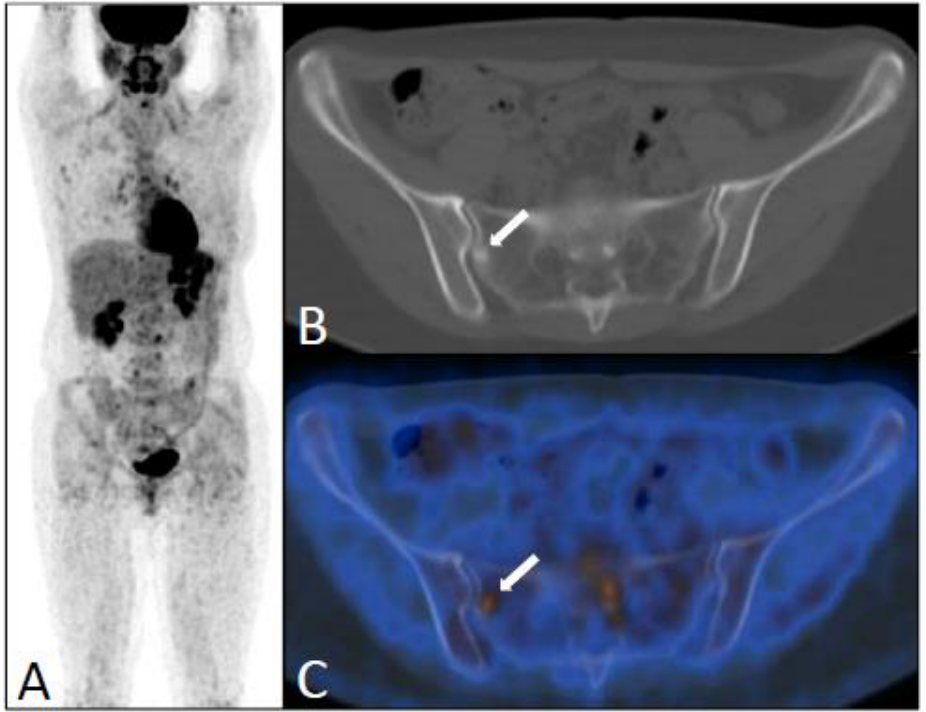
Figure 3. An FDG-PET/CT scan performed five years after the initial diagnosis of ILC (pT3N2, SBR II) of the right breast in a 37-y-old patient because of elevated tumor marker (CA 15.3 = 56) and pain in the thoracic spine. Maximum intensity projection ( A ) showing locoregional recurrence and bone metastases with low uptake. Axial CT ( B ) and PET/CT fusion images ( C ) of the pelvis showing a sclerotic lesion with low increased FDG uptake (white arrows). Hormone therapy was introduced (tamoxifen). This patient died five years later from disease progression with carcinomatous meningitis and uterine metastases.